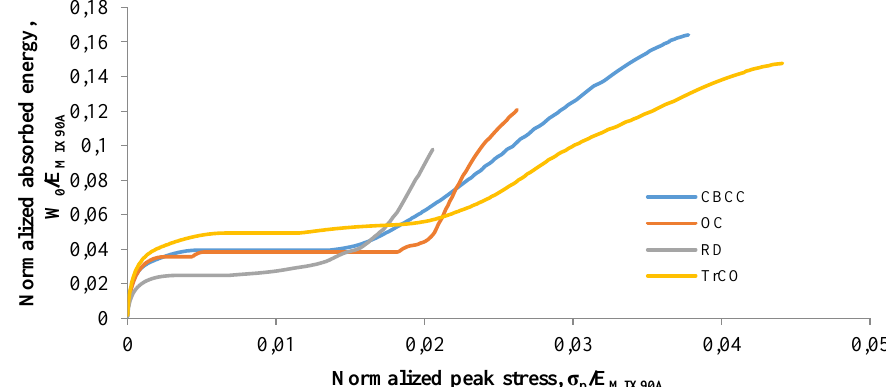
Fig. 5. Energy absorption diagram at relative density 20% for a strain 𝜀 0 =